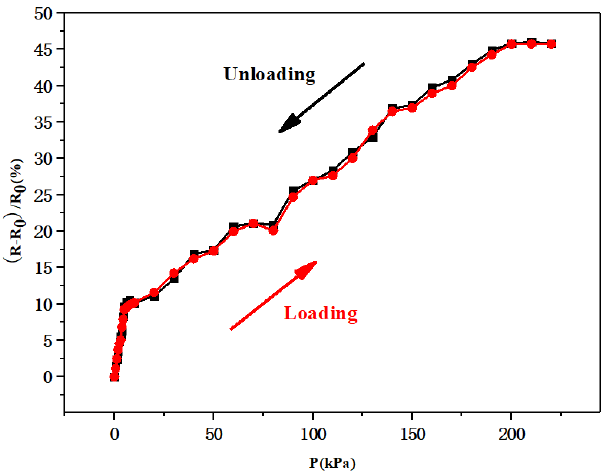
Figure 7. Relative resistance variation for the flexible pressure sensor during pressure loading and unloading.